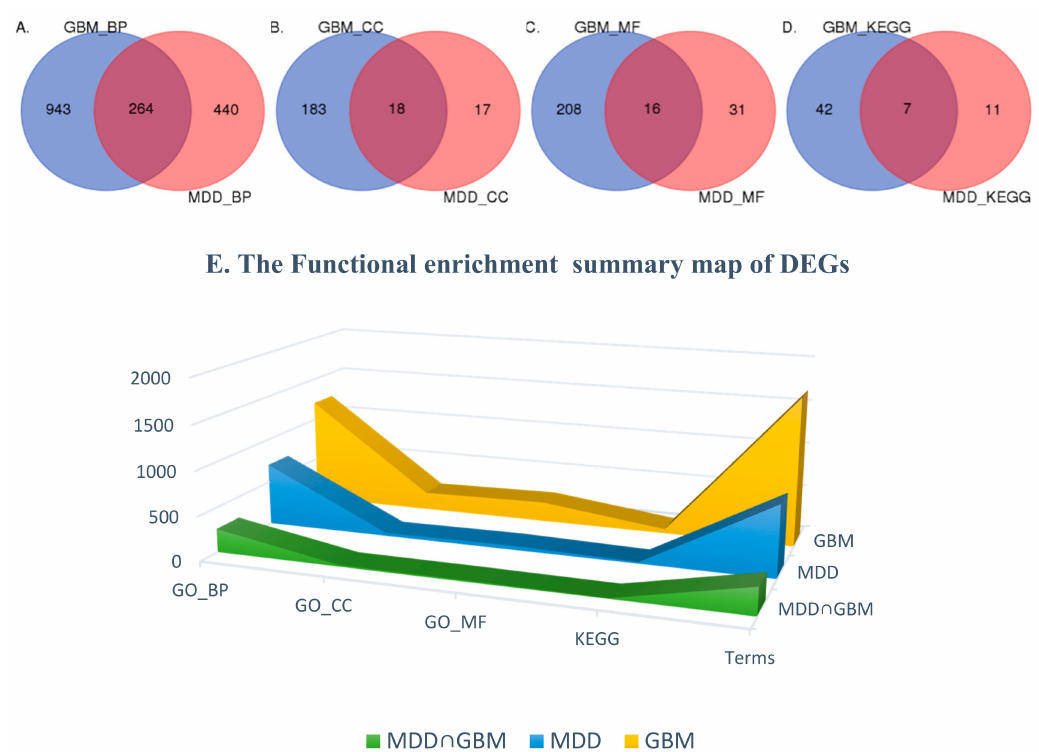
Figure 2. Differentially Expressed Genes Enrichment Venn Diagram and Its 3D Area Map. Figure ( A – D ) indicate similarities and differences in the functional enrichment results of two diseases. They are GO_BP, GO_CC, GO_MF, KEGG. In Figure ( E ), the Yellow: GBM enrichment results; blue: MDD functional enrichment results; green: MDD and GBM common enrichment results. MDD: Major Depressive Disorder; GBM: glioblastoma; BP: Biology Process; CC: Cellular Component; MF: Molecular